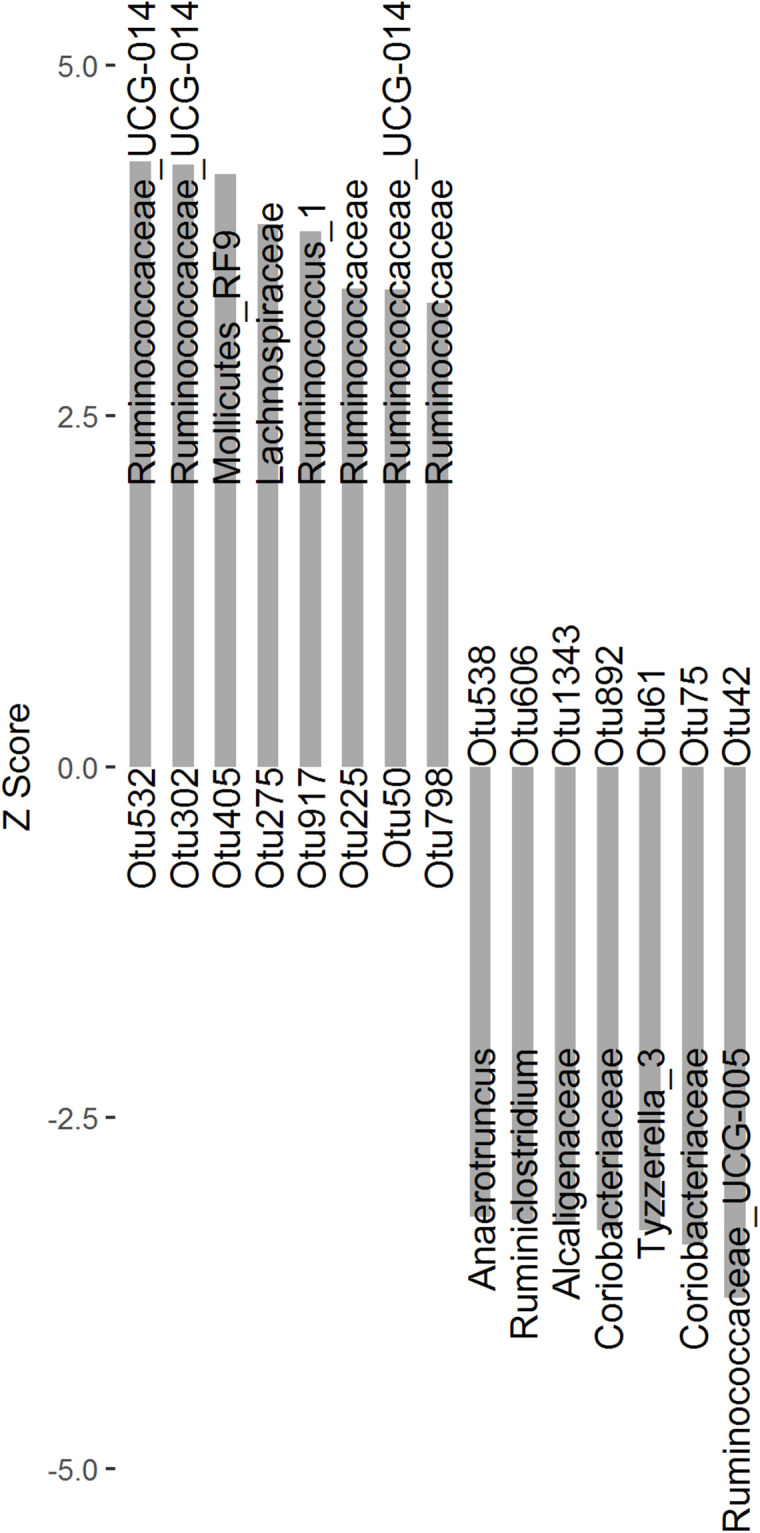
The OTUs significantly associated with finishing weight (FDR adjusted P < 0.05) are shown as Z scores.